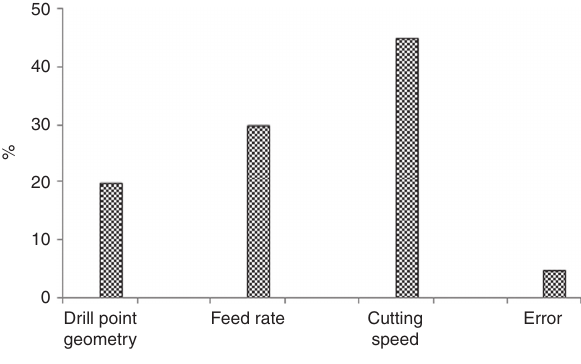
Figure 5 Percentage contribution of process